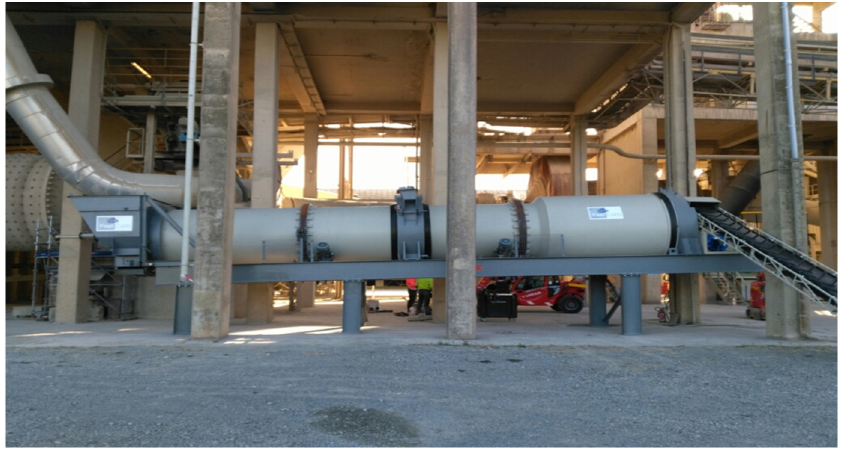
Figure 4. Rotating drum at the Vicat Créchy cement plant. The drum rotated intermittently at 4 rpm for 2 min every 15 min with an optimal residence time of 60 min for 3 t of RCA. The contents was then drained for 10 min at a speed of 10 rpm.